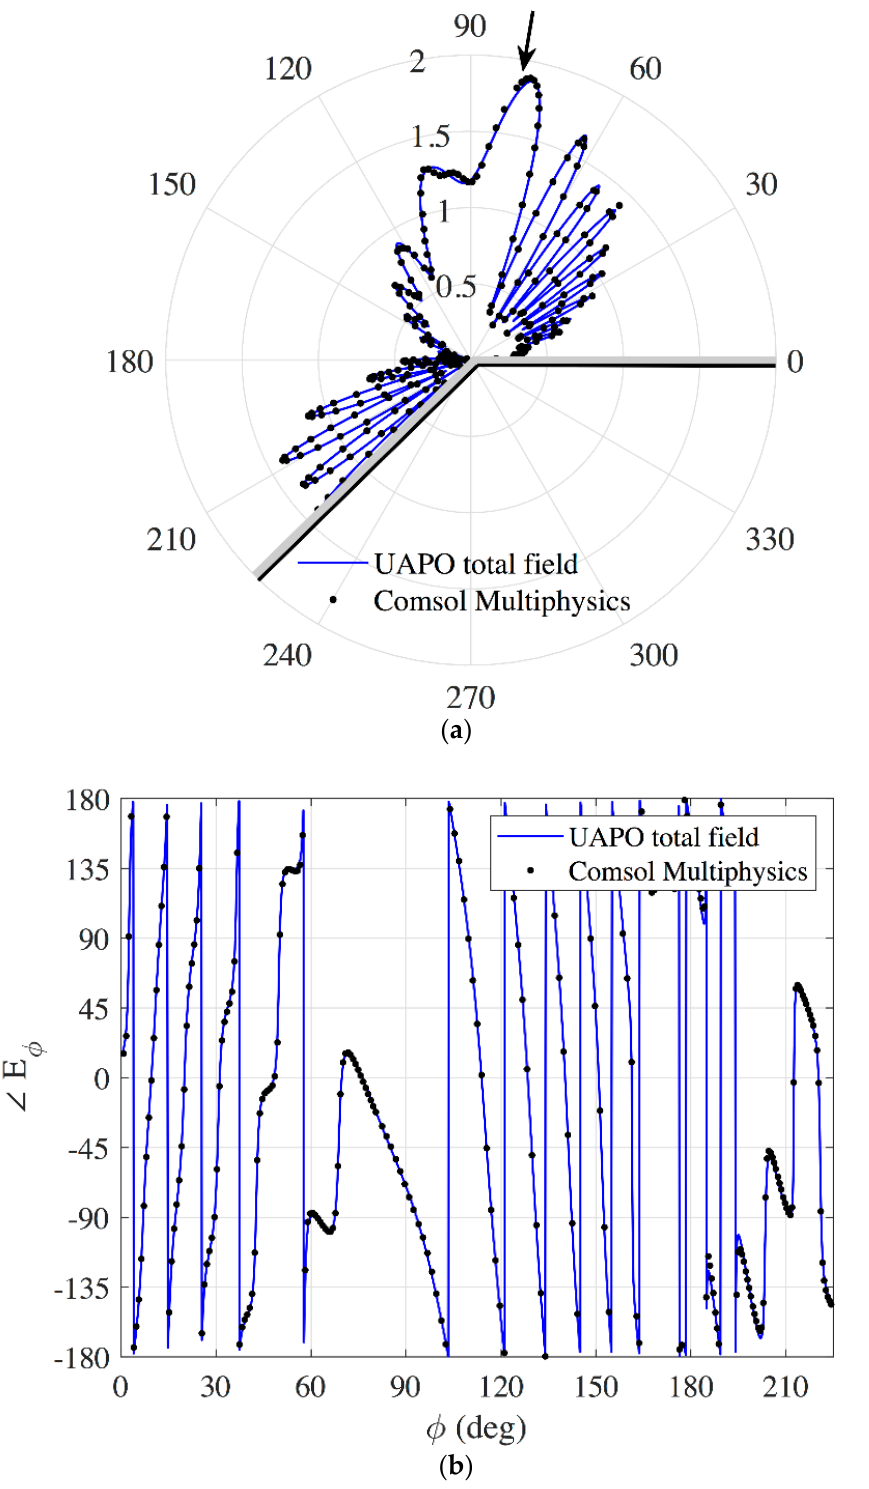
i = i = 0 , E 1 . ( a ) = 0, E i = 1. b ' f ' φ (cid:48) β (cid:48)